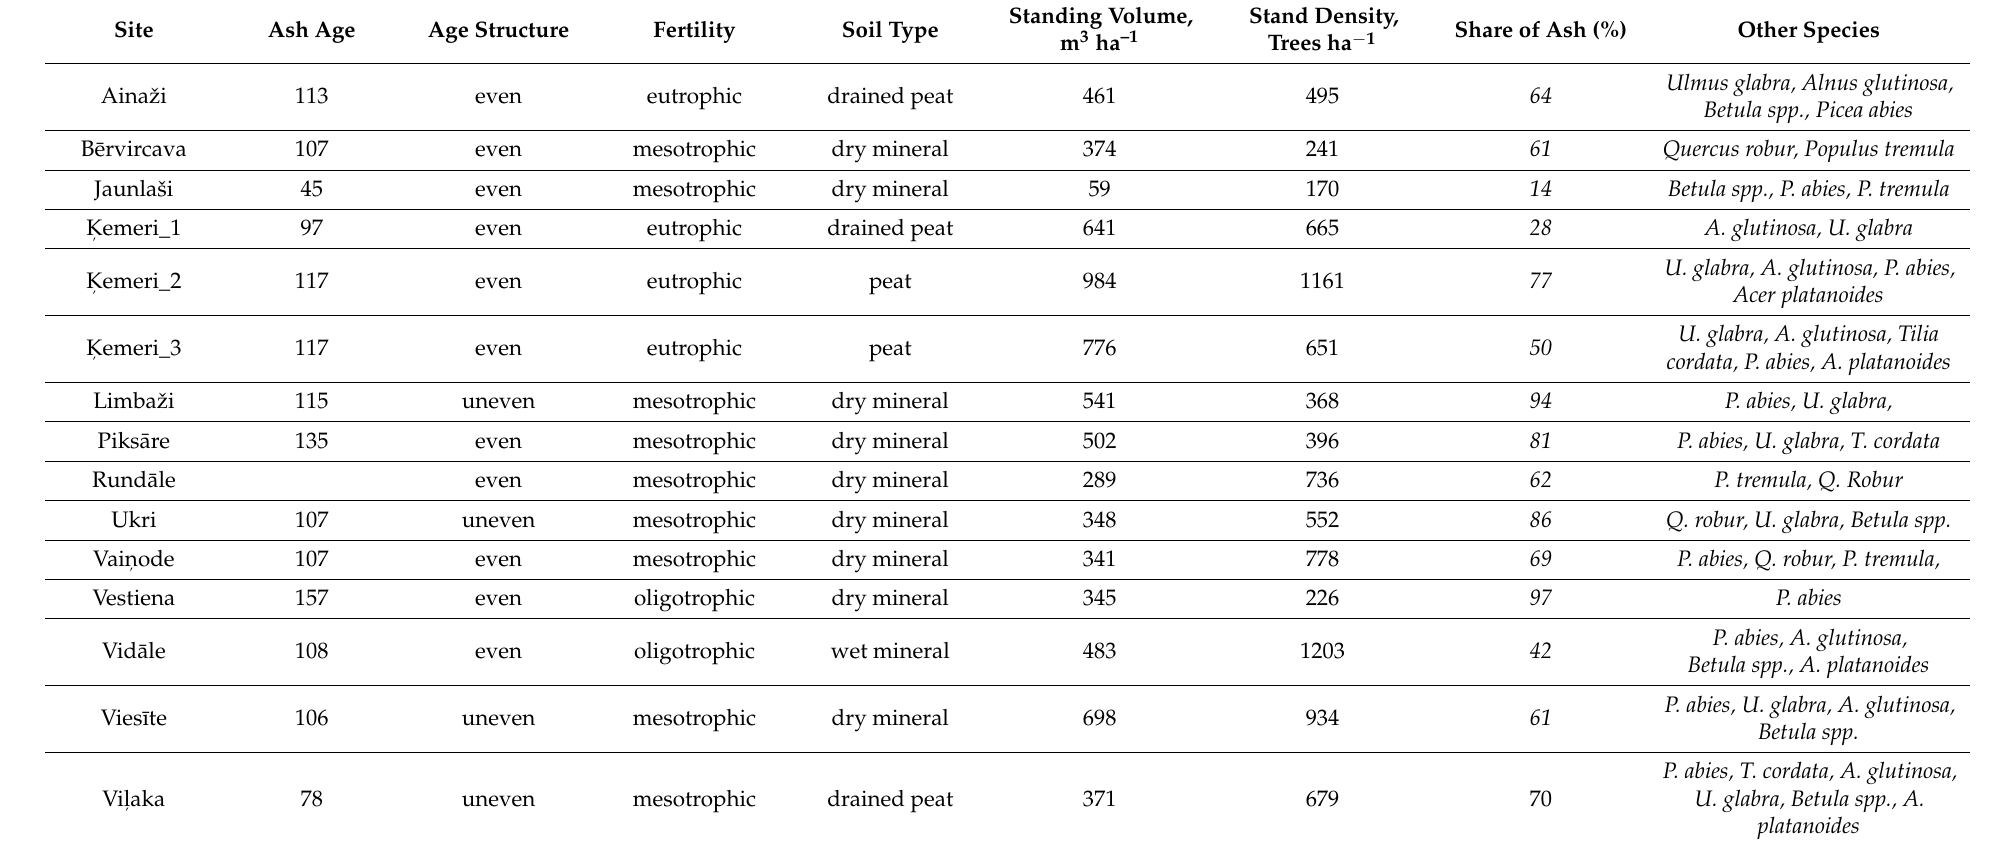
Table 1. Details of the studied permanent sampling plots at the beginning of survey in